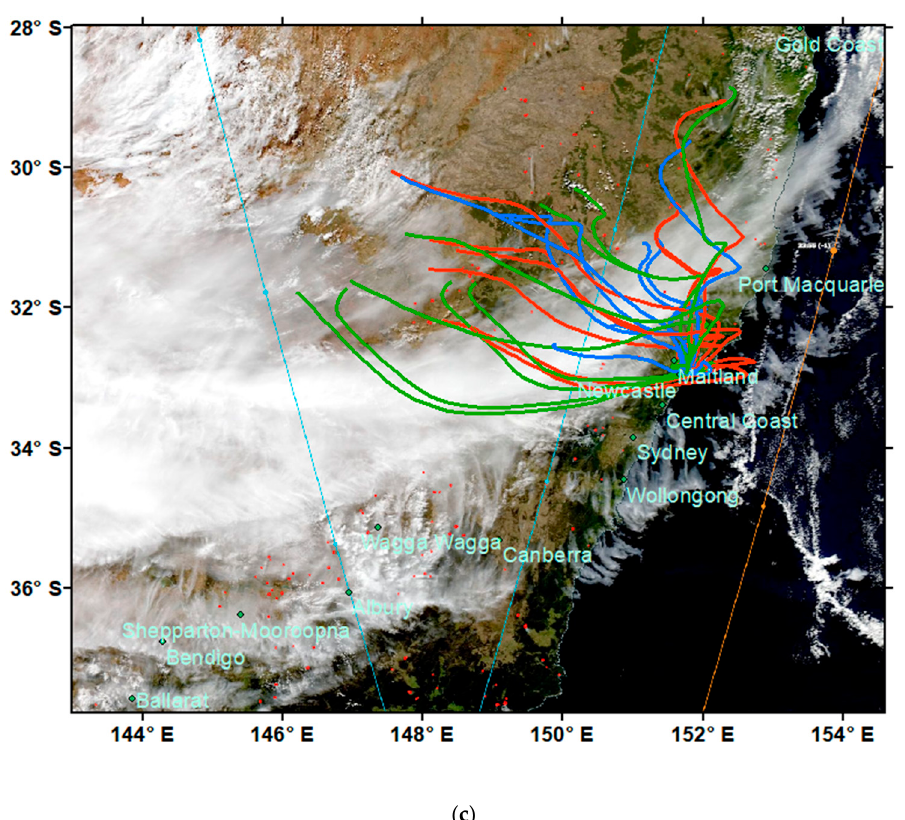
Figure 15. HYSPLIT ensemble backward trajectories overlaid on MODIS Aqua/Terra satellite images with hot spots (small red dots) for 48 h from Newcastle at 10-m height on: ( a ) 5 May 2016 08:00 AEST; ( b ) 6 May 2016 08:00 AEST; and ( c ) 7 May 2016 08:00 AEST. The Riverina region near Wagga Wagga and Albury has many hot spots (a,b). Panel (b) shows some smoke plumes originating from some of the hot spots. (c) White clouds covered much of western NSW and the north coast, north of Port Macquarie, and smoke clouds from fires are visible between Canberra and Wollongong. Each of the different colour trajectories represents one ensemble member of the trajectory analysis.